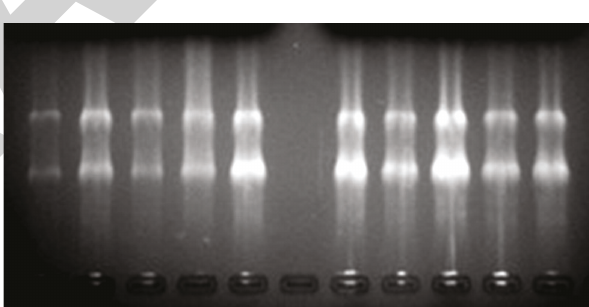
(transcription) factor in the nucleus to promote cell divi- sion genes. The accumulation of 𝛽 -catenin would lead to abnormal activation of the downstream transcription factors after transferring to the nucleus, which mainly cause